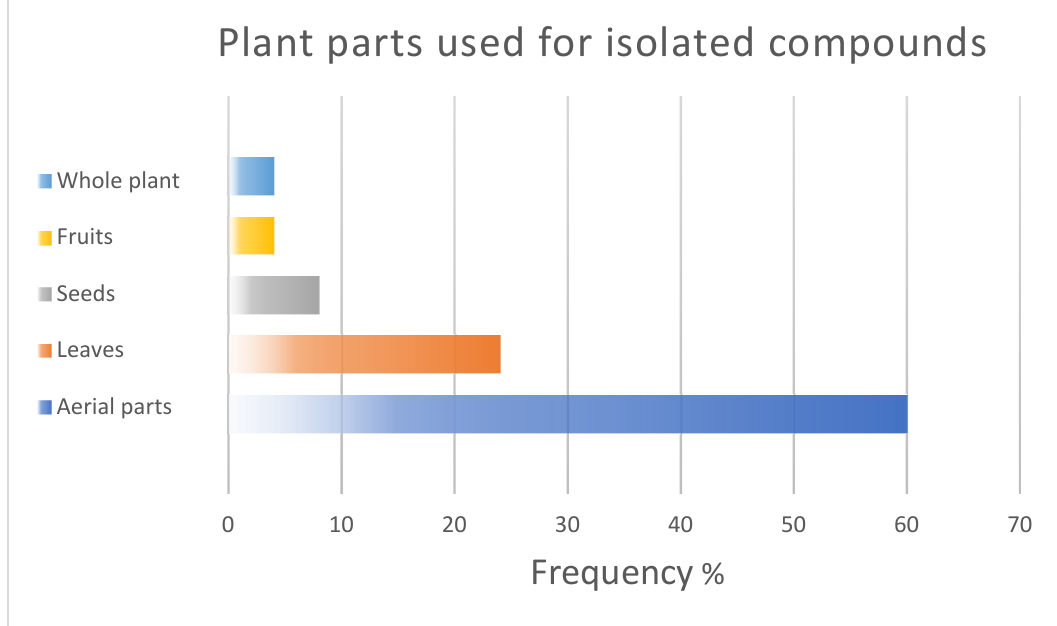
Figure 6. Plant parts that are commonly used for the isolation of bioactive compounds.